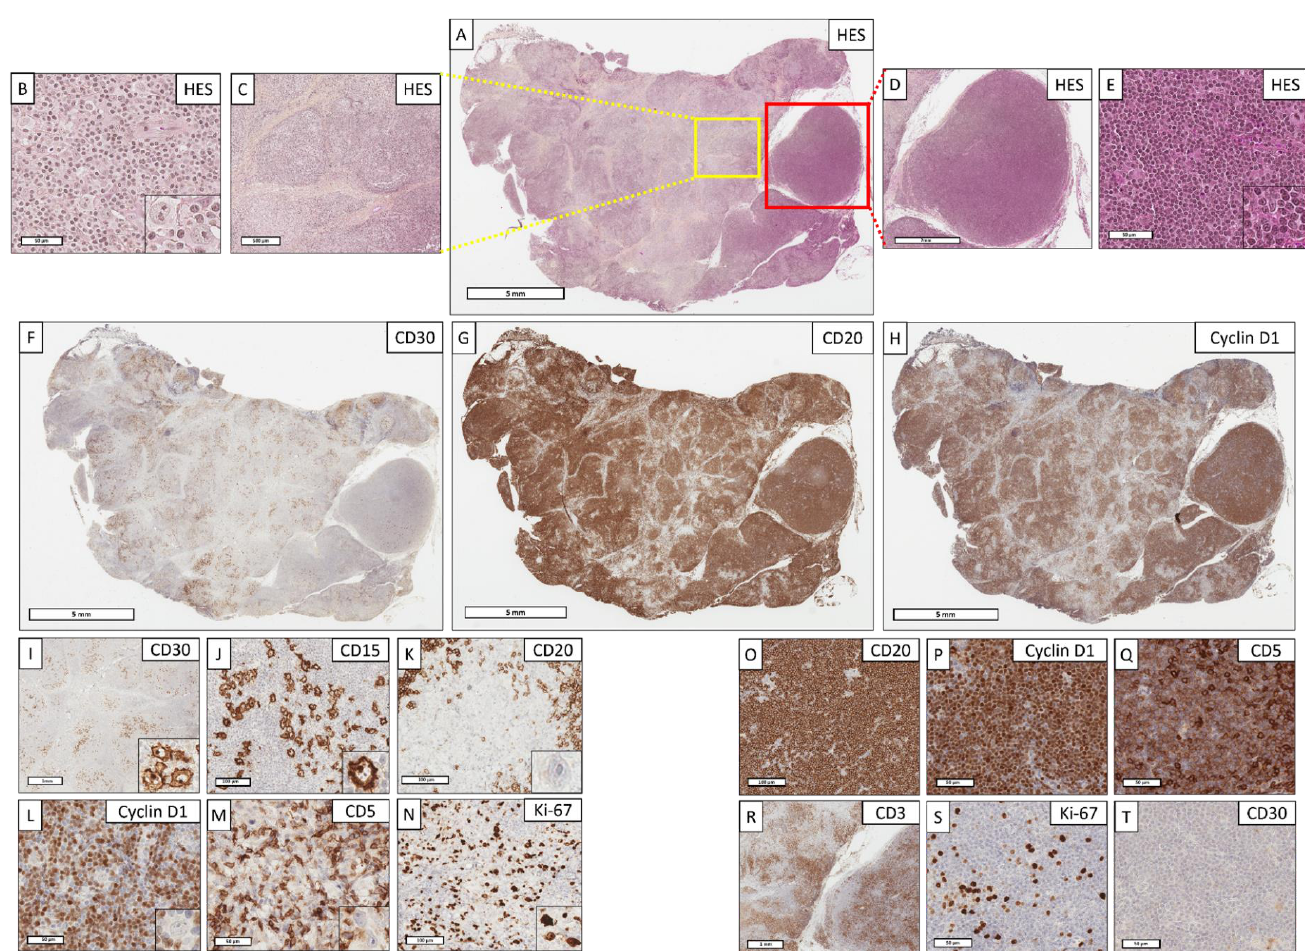
Figure 2. A cHL/mantle cell composite lymphoma with mixed contingents: how to differentiate Hodgkin cells from Hodgkin-like cells? ( A ) (Hematoxylin–eosin–saffron (HES), × 4). Lymph node with a completely remodeled architecture. The tumor proliferation is nodular and diffuse. ( B ) (HES, × 400); ( C ) (HES, × 40, corresponding to yellow box from ( A ). The cHL contingent organization is nodular, delimited by a marked collagenous fibrosis/sclerosis. This contingent is composed of a rich epithelioid histiocytic stroma within which are Hodgkin cells with an atypical nucleus and a large eosinophilic nucleolus. ( D ) (HES, × 16, corresponding to red box from ( A ); ( E ) (HES, × 400). The mantle cell lymphoma contingent organization is diffuse and nodular, consisting of small, slightly atypical cells. ( F ) (CD30, × 4); ( G ) (CD20, × 4) and ( H ) (Cyclin D1, × 4). The anti-CD30 antibody highlights the nodular organization of cHL (localized on the left side of the lymph node), whereas the CD20 and Cyclin D1 antibodies at low magnification highlight the mantle cell lymphoma contingent (predominantly localized on the right side of the lymph node, but also mixed with cHL on the left). ( I ) (CD30, × 20); ( J ) (CD15, × 200); ( K ) (CD20, × 400); ( L ) (Cyclin D1, × 400); ( M ) (CD5, × 400). Hodgkin cells intensely and diffusely express CD30 and CD15, but do not express CD20, Cyclin D1, or CD5. ( N ) (Ki67, × 400). The proliferative index highlights the large Hodgkin cells. ( O ) (CD20, × 200); ( P ) (Cyclin D1, × 400); ( Q ) (CD5, × 400); ( R ) (CD3, × 20); ( S ) (Ki67, × 400); ( T ) (CD30, × 400). The mantle cell lymphoma contingent expresses intensely and diffusely CD20, CD5, and Cyclin D1, without expression of CD3. The tumor cells express CD5 less intensely than adjacent reactive T cells, also expressing CD3. The proliferative index is weak (<10%). In this example, the diagnosis is a cHL/mantle cell composite lymphoma rather than Hodgkin-like cells of a mantle cell lymphoma, since there is a compatible architectural change (sclerotic and nodular), a cHL histiocytic stroma, positive cHL markers (CD30 and CD15) [36,59], and a lack of expression of other markers by the cHL contingent (CD20, CD5, Cyclin